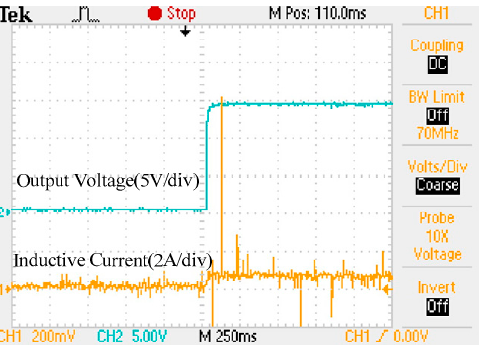
Figure 12. Experimental start ‐ up waveforms of the output voltage and inductive current under the terminal sliding mode (TSM) controller.